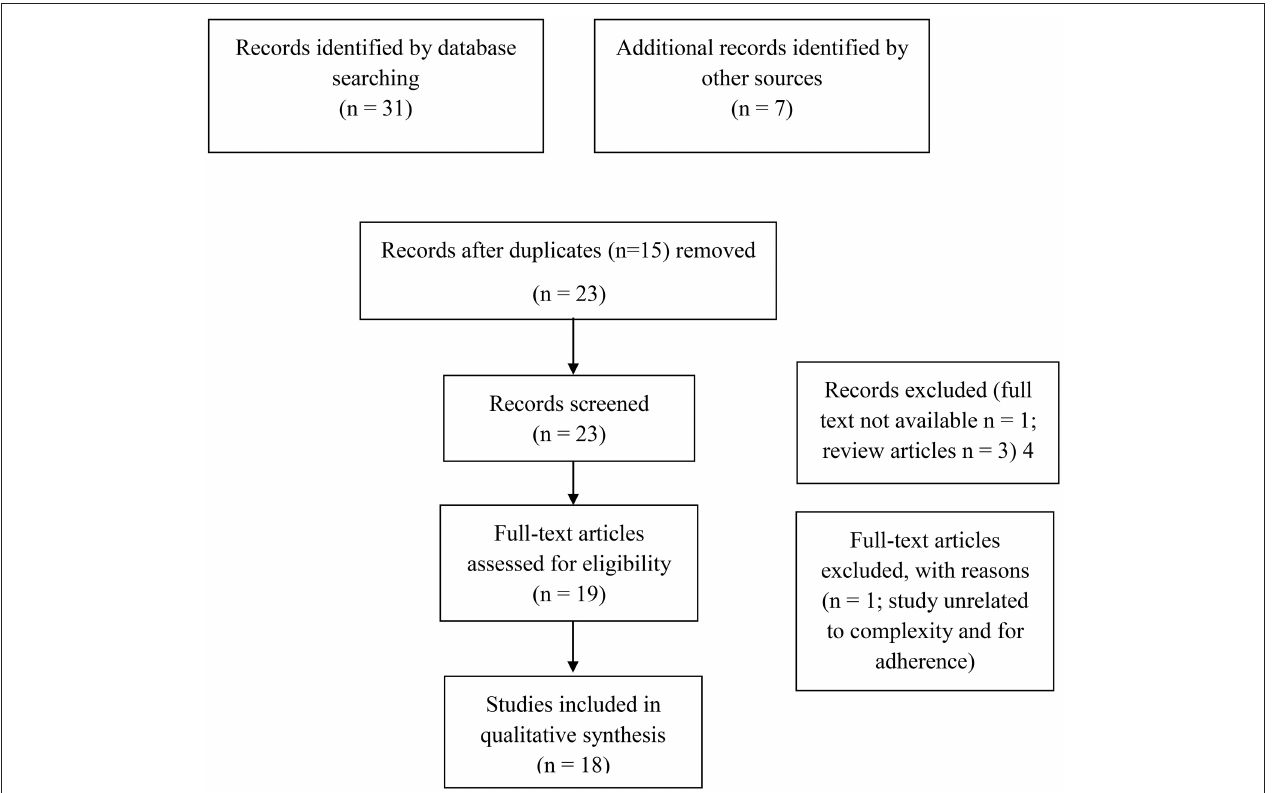
FIGURE 1 | PRISMA flow